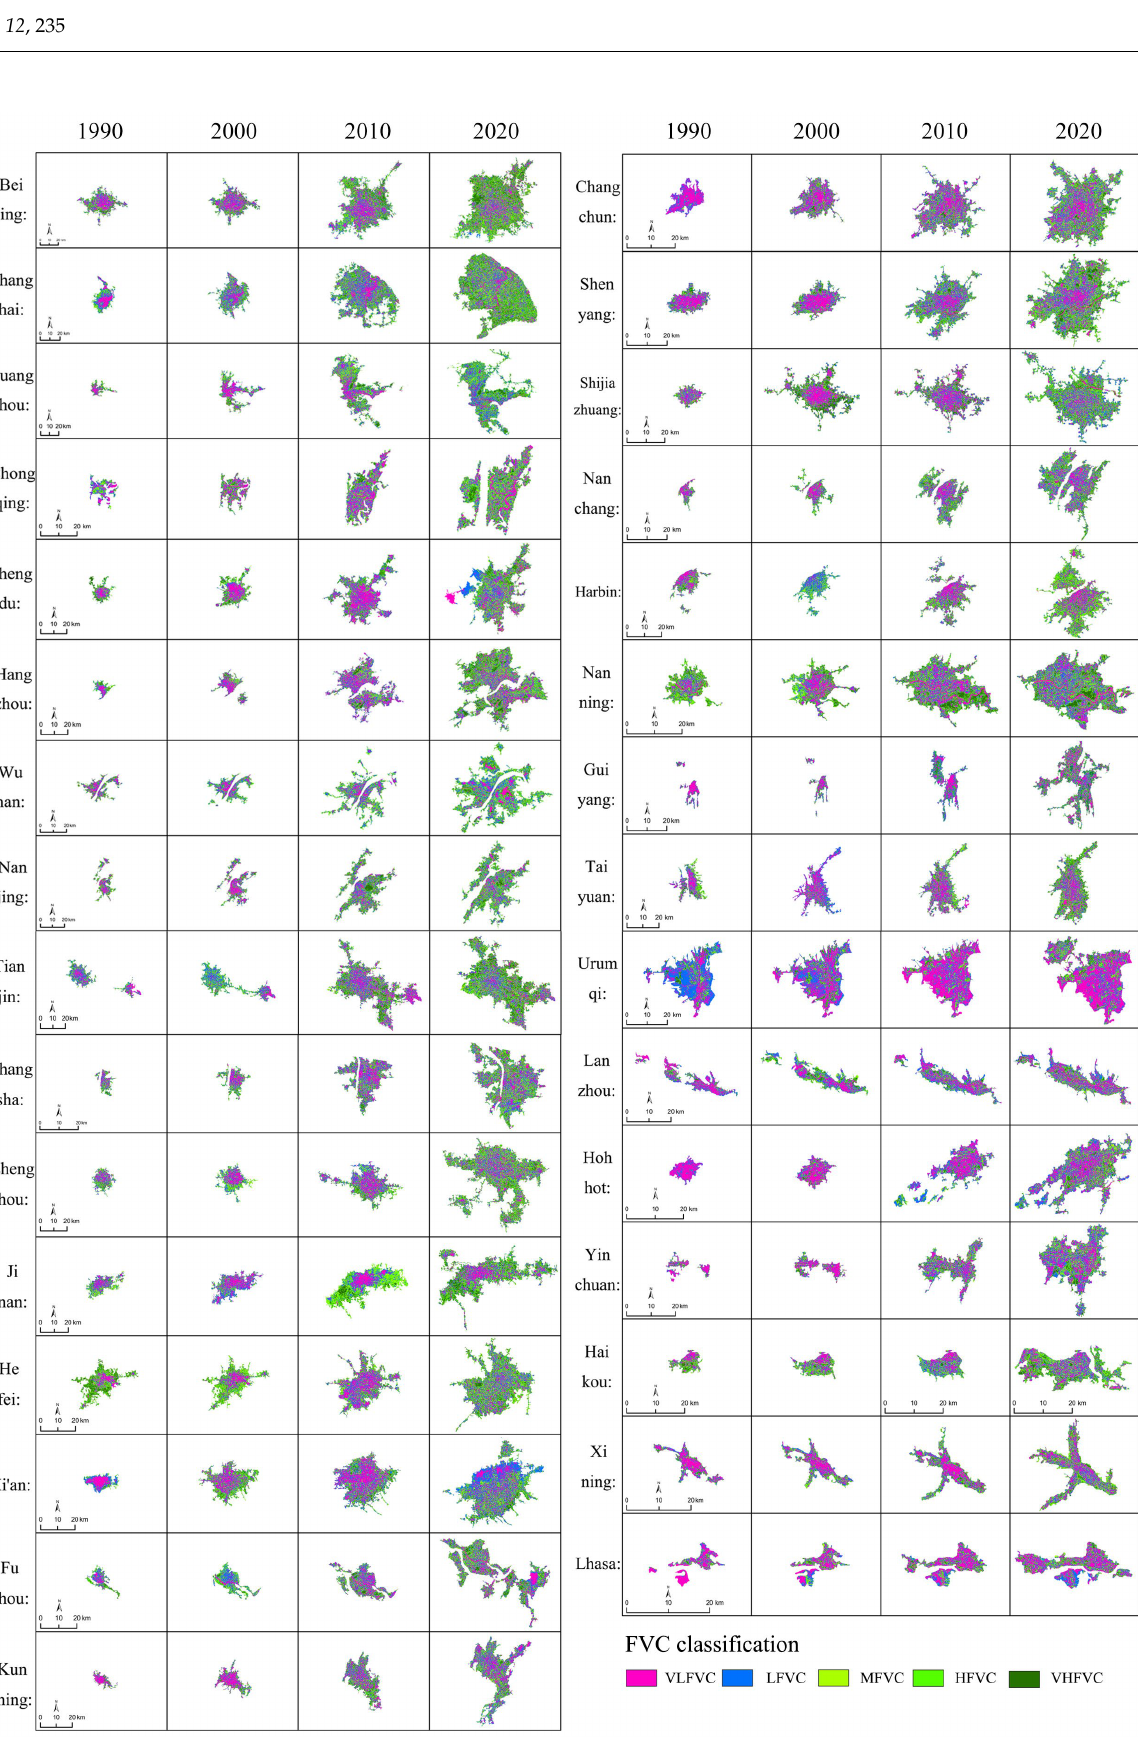
Figure 4. FVC hierarchical chart in built-up areas of provincial capital cities from 1990 to 2020. (VLFVC: very low FVC; LFVC: low FVC; MFVC: medium FVC; HFVC: high FVC; VFVC: very High FVC).